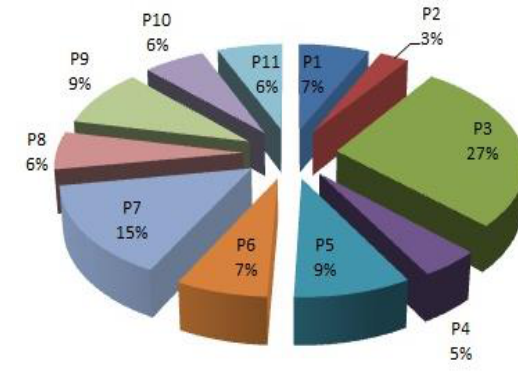
Figure 3: Breakdown of carbon footprint of welding processes according to the percentage.